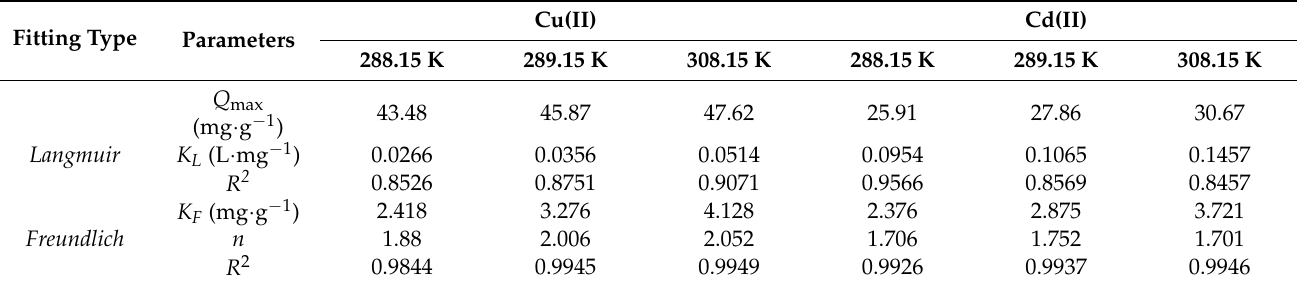
Table 4. Fitting parameters of adsorption thermodynamics for BHW adsorption of Cd 2+ and Cu 2+ .